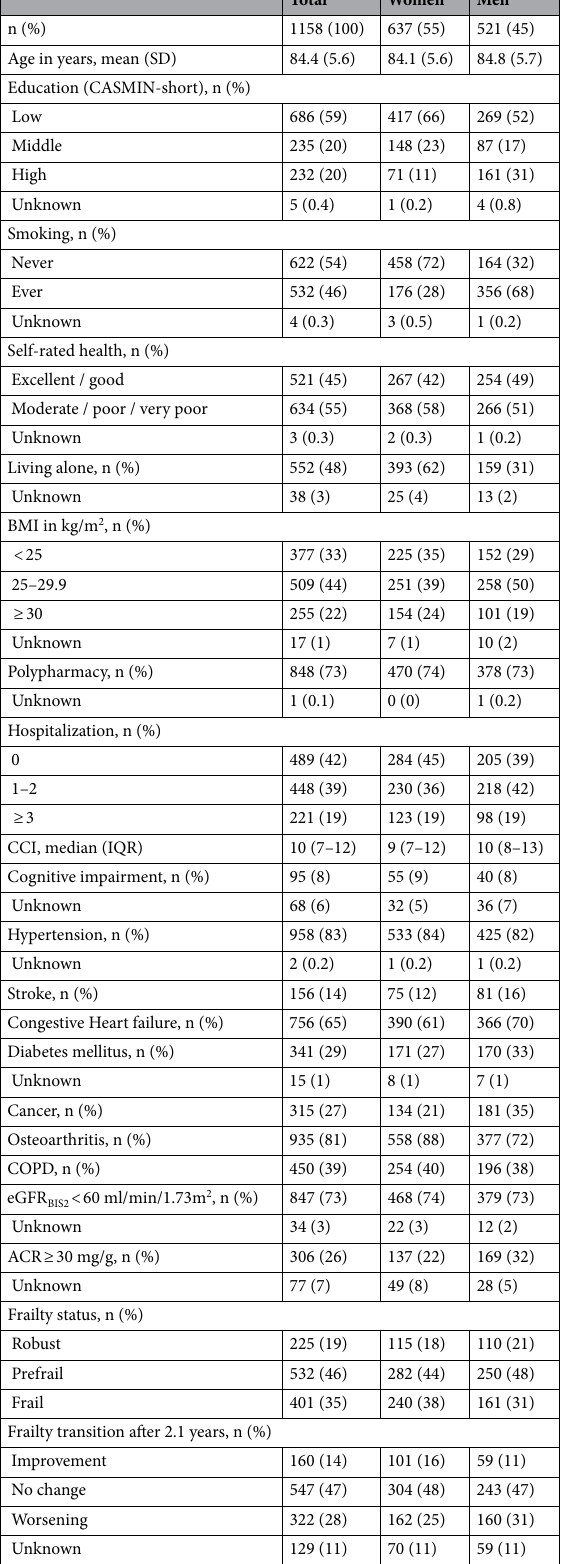
Table 1. Main baseline characteristics by gender. SD standard deviation, BMI body mass index, CCI Charlson Comorbidity Index, COPD chronic obstructive lung disease, eGFR estimated glomerular filtration rate, ACR albumin to creatinine